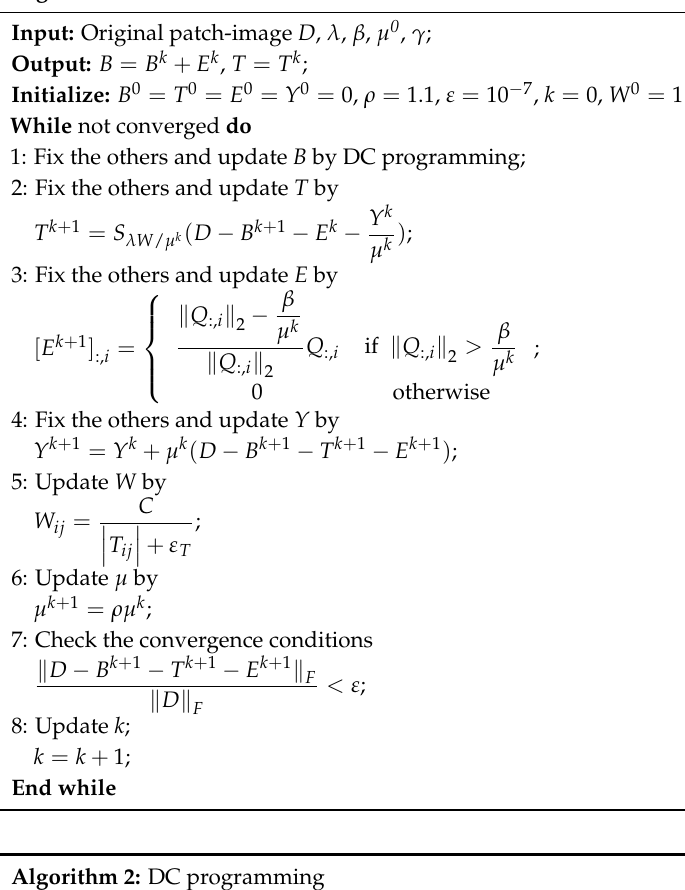
Algorithm 1: ALM/DC solver to the NRAM model